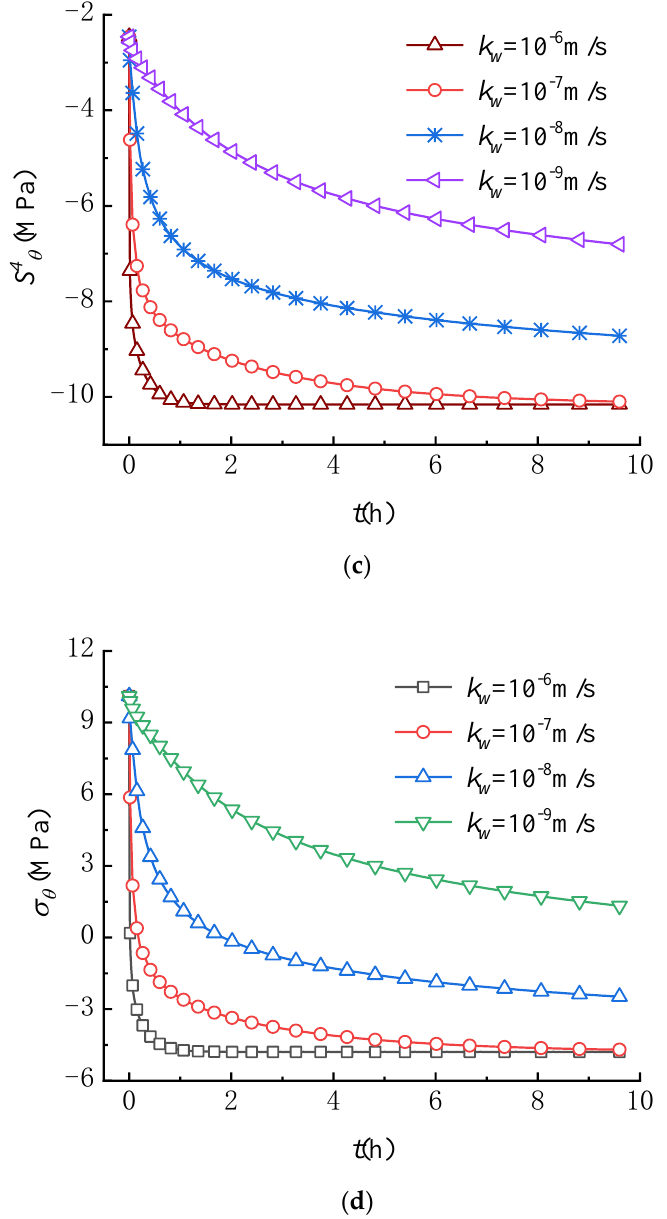
 with different hydraulic conductivity and ( d )  